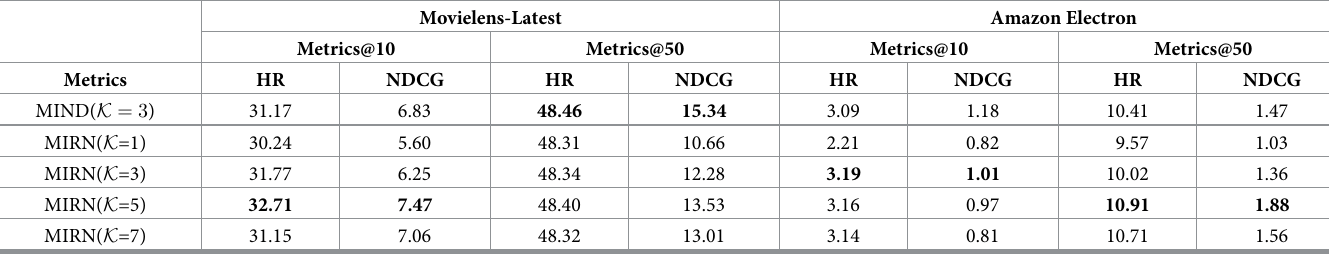
Table 5. Model performance for different parameters K .